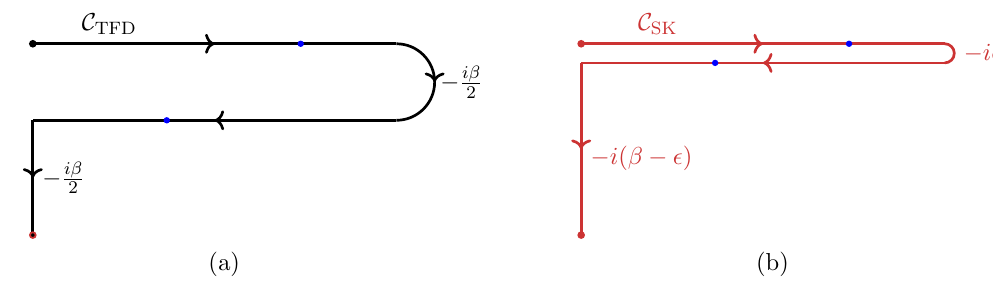
Figure 1 . A comparison of the (a) thermo(cid:12)eld double and (b) Schwinger-Keldysh complex time contours for a system prepared in a thermal state. The starting and end points of the contour are identi(cid:12)ed. The associated Euclidean (imaginary time) periodicity is set by the inverse tempera- ture (cid:12)